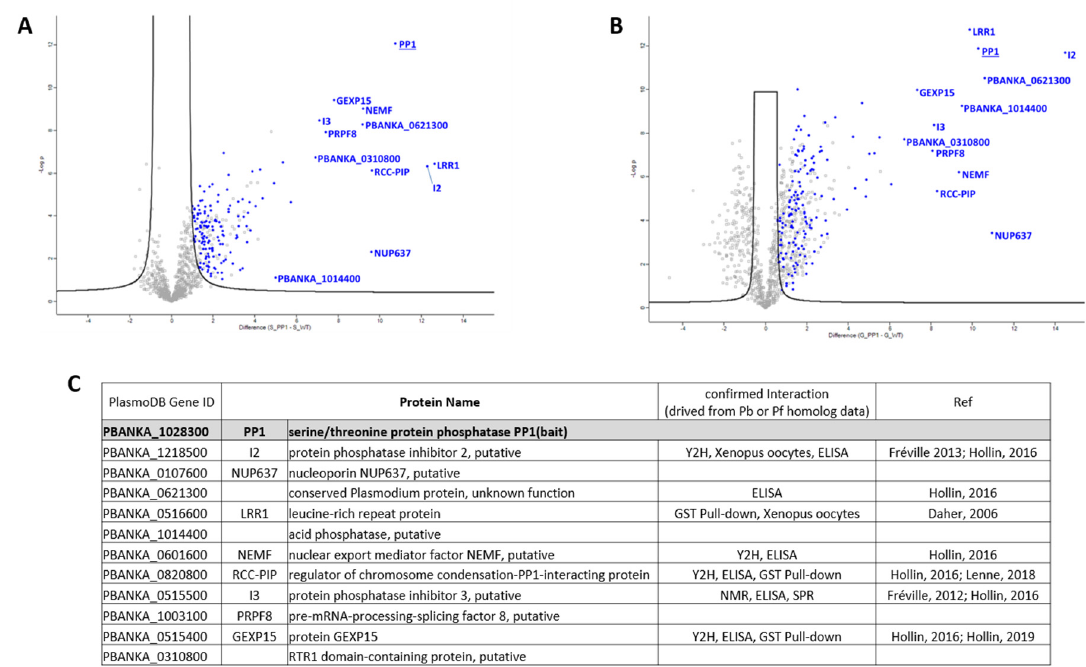
Figure 2. PbPP1c interactome analysis. ( A , B ) Volcano plot representations of the outcome of the PbPP1c interactome study carried out in schizonts ( A ) and in gametocytes ( B ). Highlighted in blue are the common interacting proteins (CIPs) in PbPP1c interactomes in schizont and gametocyte stages. The top PbPP1c-interacting proteins are annotated (see C ). ( C ) List of top PbPP1c-interacting partners. Proteins were ranked according to their Student’s t -test difference PbPP1c–PbWT in schizont and gametocyte stages, and the top 10 proteins at each stage are listed. Protein description was updated using PlasmoDB relapse 54 (September 2021). Confirmed interaction data from previous works are in the two last columns [11,12,14,16–18]. Y2H and NMR stand for yeast 2-hybrid and nuclear magnetic resonance,